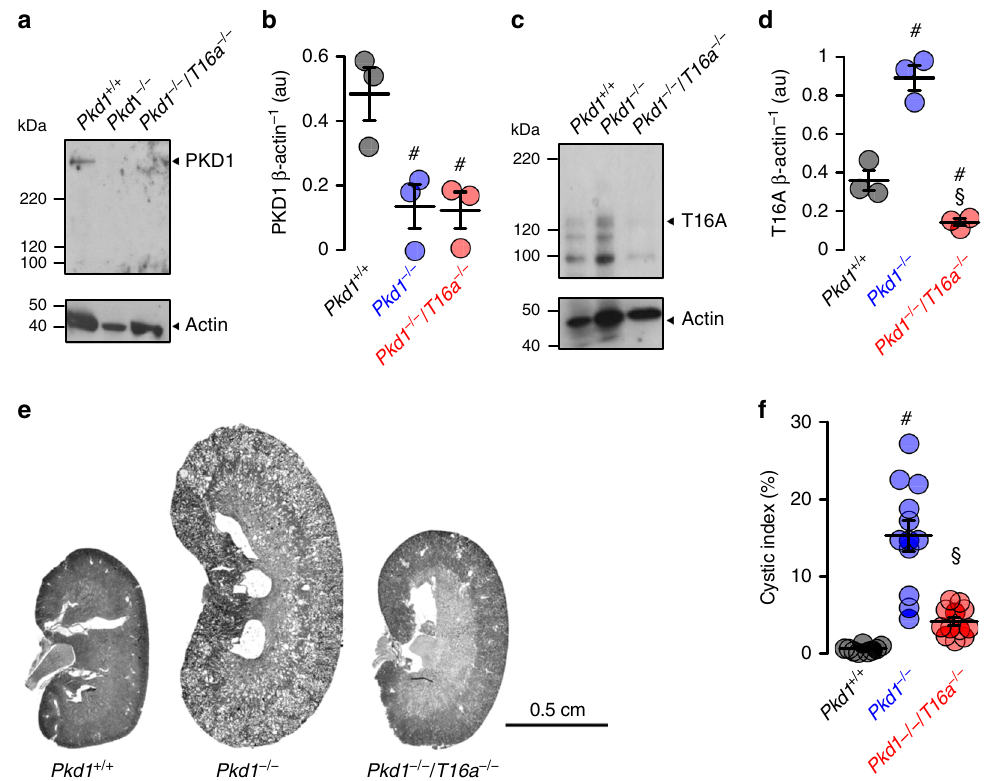
Fig. 2 Tubule-speci fi c deletion of TMEM16a reduces cyst progression in an ADPKD mouse model. a – d Western blotting from whole kidney lysates detecting tubule-speci fi c deletion of Pkd1 (450kDa) ( # P = 0.03) and increase in TMEM16A expression (glycosylated 130kDa and non-glycosylated forms 34 ) ( # P = 0.003) (10 weeks after induction at postnatal days 20 – 22 using tamoxifen. Mice co-deleted for Pkd1 and Tmem16a ( Pkd1 − / − / T16a − / − ) showed reduced Pkd1 expression ( # P = 0.022) and TMEM16A expression ( § P = 0.0004) ( n = 3 animals each). e , f Tubule-speci fi c knockout of Pkd1 ( Pkd1 − / − ) induced polycystic kidney disease ( # P <0.0001, n = 11 animals), which was largely reduced in mice with an additional knockout of Tmem16a ( Pkd1 − / − / T16a − / − ) ( § P = 0.0001, n = 11 animals). Non-induced Pkd1 fl ; fl mice served as control ( Pkd1 + / + ) ( n = 8 animals). Corresponding cystic indices (de fi ned as cortical cyst area normalized to whole cortex area). Mean and error bars indicating ±SEM. # Unpaired two-sided t test comparing Pkd1 + / + with Pkd1 − / − , § unpaired two-sided t test comparing Pkd1 − / − with Pkd1 − / − / T16a − / − . Source data are provided as a Source Data fi